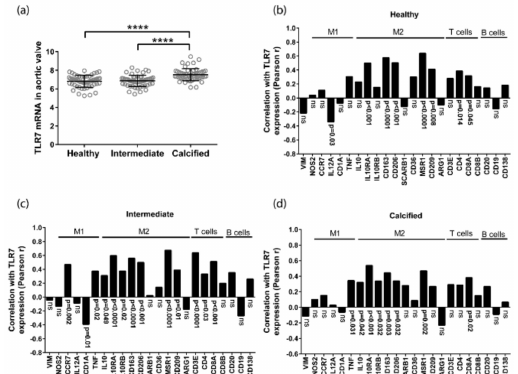
Figure 1. TLR7 correlates with M2 macrophage markers in healthy, intermediate, and calcified parts of the aortic valve. ( a ) TLR7 mRNA levels were significantly increased in calcified compared with healthy and intermediate parts of the aortic valve ( n = 55). 1-way RM ANOVA with Holm-Sidak post-hoc test, **** p ≤ 0.0001. ( b – d ) Correlation analysis of TLR7 mRNA levels with mRNA levels of the VIC marker gene vimentin as well as immune cell markers in healthy ( b ), intermediate ( c ), and calcified ( d ) parts of human aortic valves ( n = 55). Pearson correlation and false discovery rate (FDR) adjusted p -values are presented. Table 1. Gene expression of TLR7 in healthy, intermediate, and calcified parts of the aortic valve. Calcified vs Calcified vs Intermediate vs Healthy Intermediate Healthy Fold change TLR7